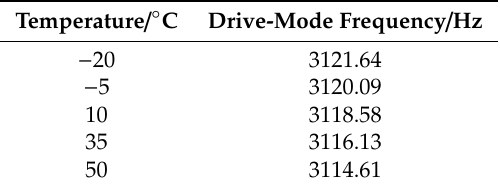
Table 1. Measured frequency–temperature dependence.